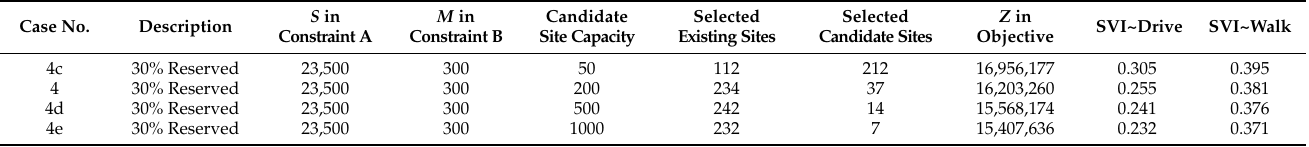
Table 3. Model results with different candidate site